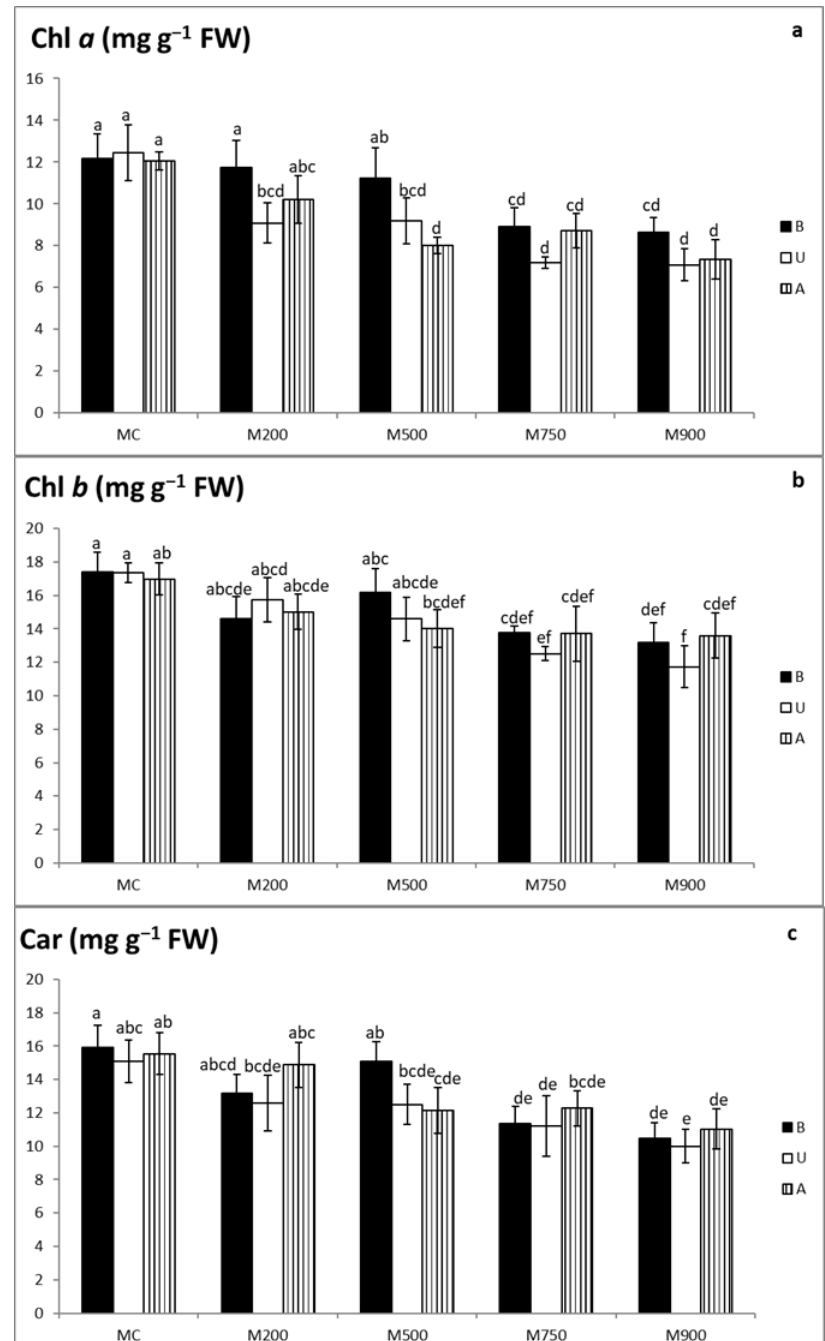
Figure 3. Chlorophyll, Chl a , b ( a , b ) and carotenoid, Car ( c ) contents in the leaves of three different miscanthus cultivars (B, U, and A) cultivated in soils with gradient TE concentration (MC-control, M200, M500, M750, and M900). Values are presented as means ± SD. Different letters refer to significant differences between plants (Turkey HSD test, n = 5, p ≤ 0.05).